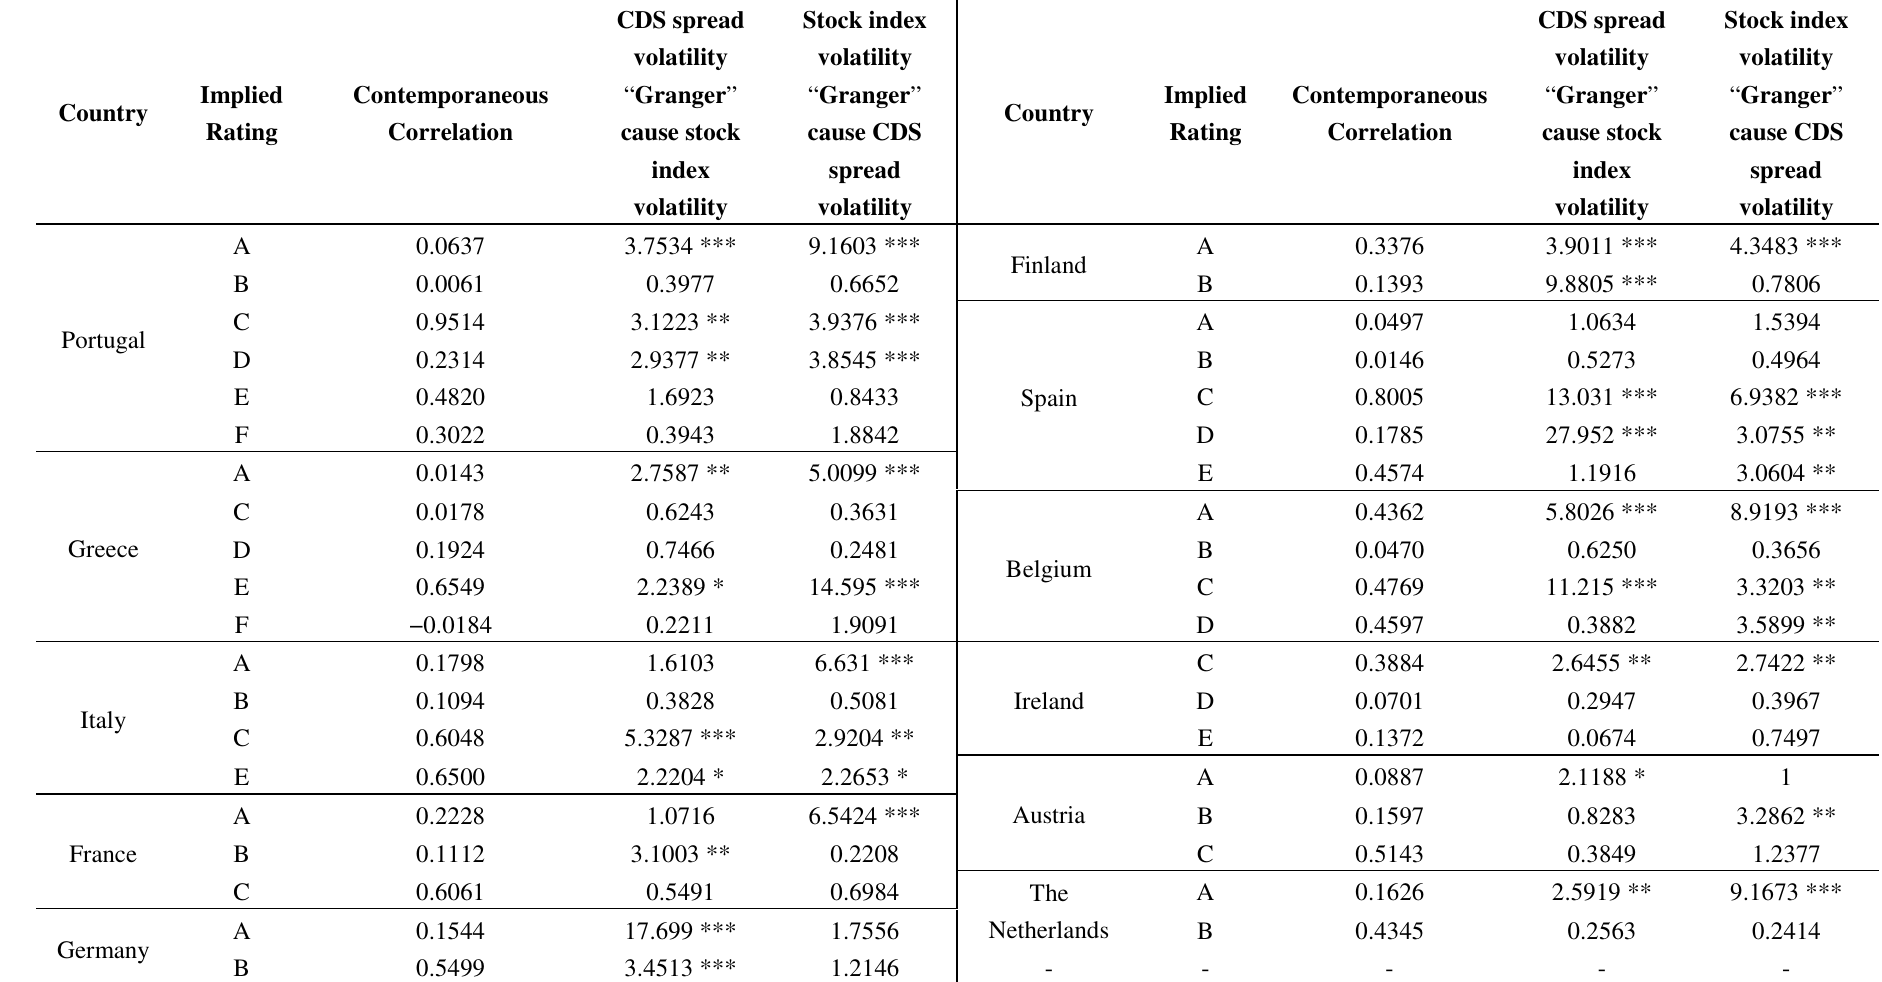
Table 8. Volatility spillovers across stock markets and CDS